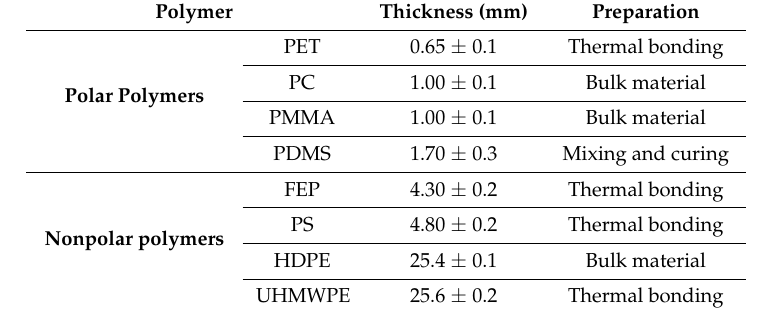
Table 1. Thicknesses (as defined at the centre) of the polymer samples used in the THz-TDS analyses. Polymer